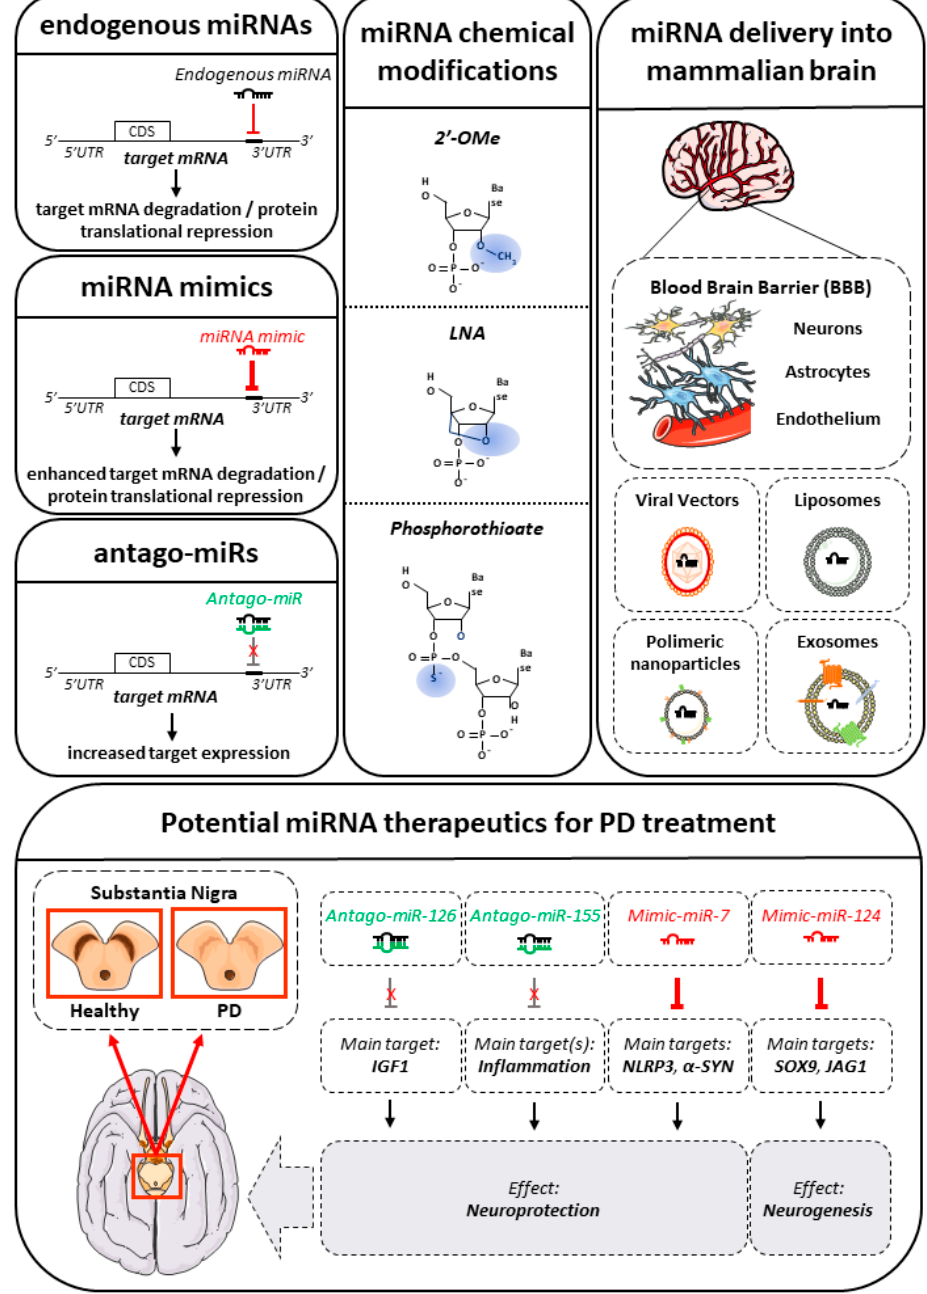
Figure 3. Development of miRNA-based therapies for PD treatment. The three panels on the top left show the mechanisms of action of endogenous miRNAs (in black), miRNA mimics (in red) and antago-miRs (in green). Mimics are able to bind their target sequence, thus mimicking the effects of the corresponding endogenous miRNA (in red the inhibitory arrow indicating their effect on the specific target sequence). On the contrary, the antago-miRs bind and block the specific endogenous miRNAs, which are, consequently, unable to bind the target sequence. The top central panel shows the most used chemical modifications stabilizing miRNA mimics and antago-miRs backbones. On the top right panel the main delivery methods used to carry miRNA mimics and antago-miRs across the BBB (i.e., viral vectors, liposomes, polymeric nanoparticles and exosomes). On the low-bottom panel, four miRNAs potentially useful as new therapeutics and their functional effects in the context of PD.